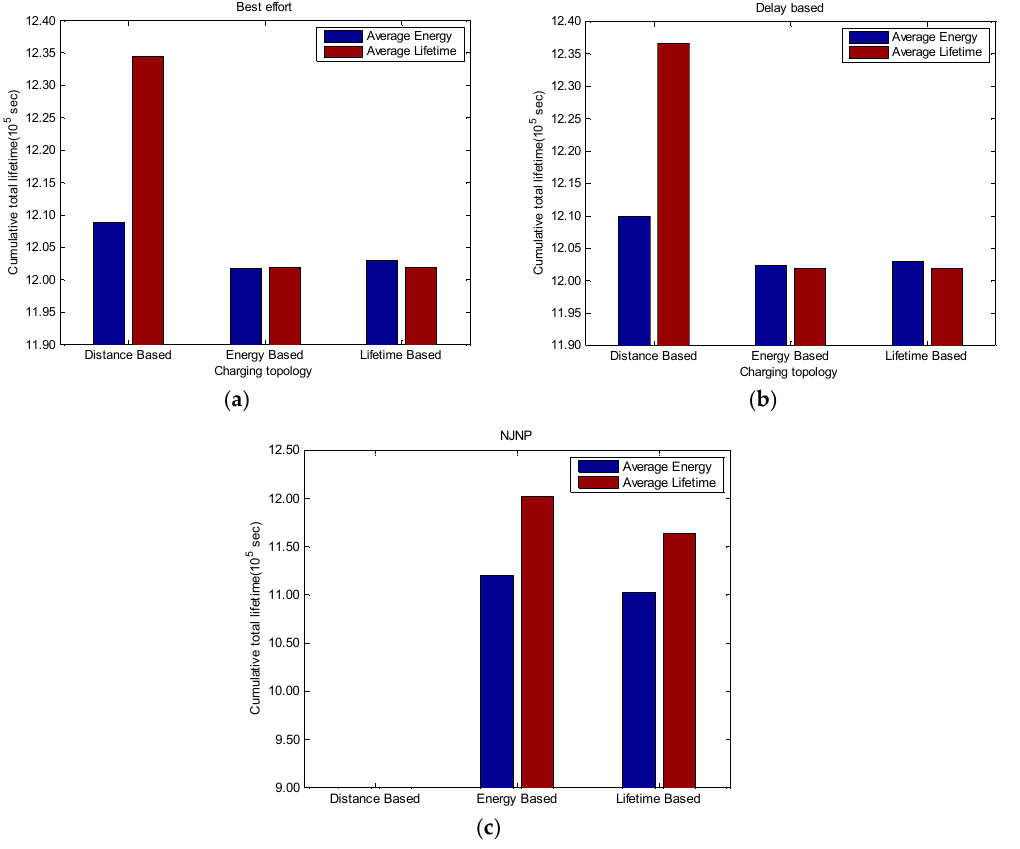
Figure 9. The combination experiment of MMCS with different charging scheduling module ( a ) MMCS with the best effort-charging module; ( b ) MMCS with delay-based charging module; and ( c ) MMCS with NJNP.